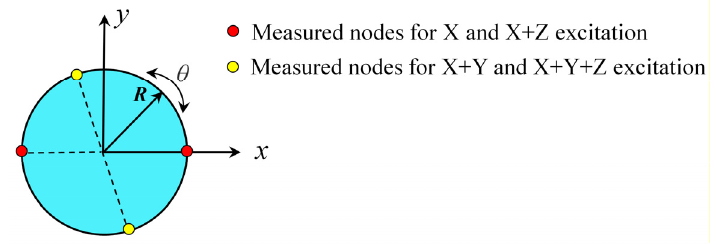
Figure 5. Selected feature points for analysis (plan).